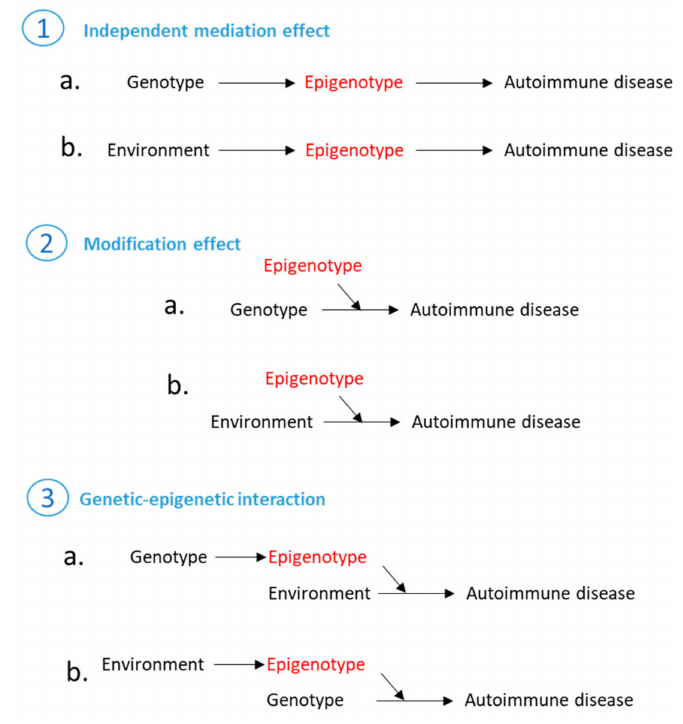
Figure 2. Schematic representation of three modes of actions where epigenetic regulations can take place to contribute to autoimmune disease risk. Figure was adapted and modified from